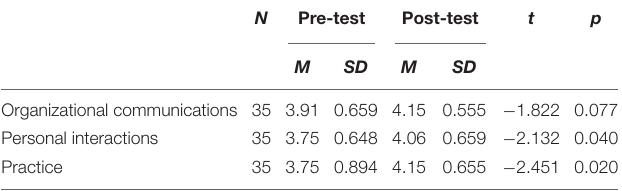
TABLE 7 | The paired sample T -test of dimensions of knowledge sharing.